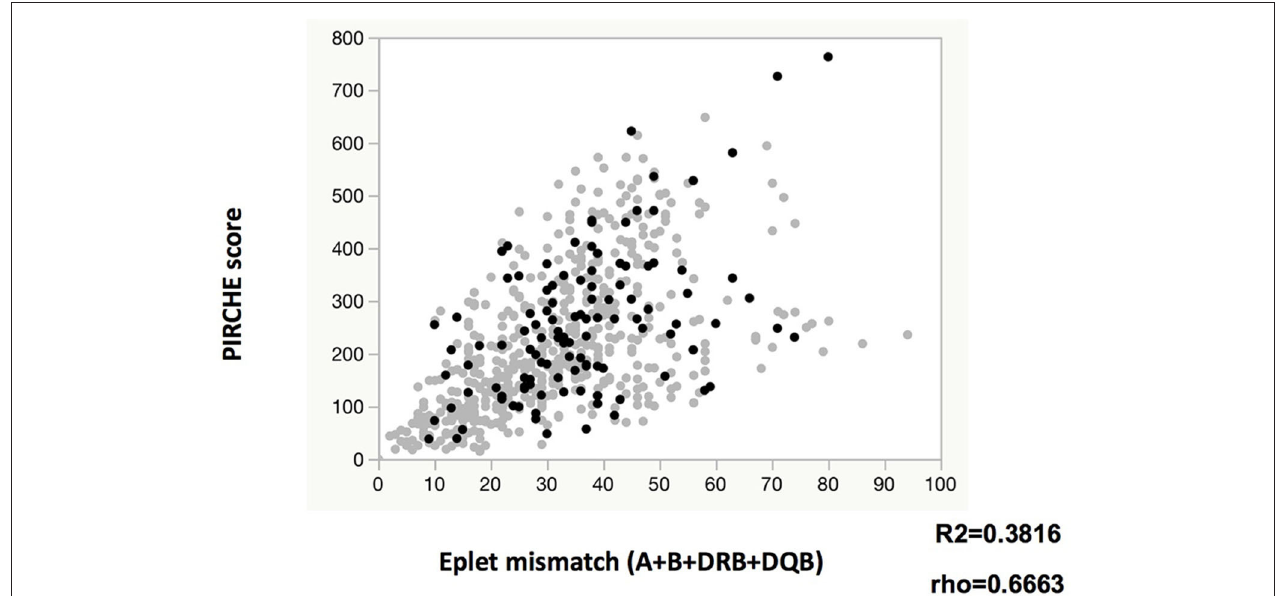
FIGURE 1 | Relationship between eplet mismatch and PIRCHE score. Gray circles and black circles indicate de novo DR/DQ DSA negative and positive, respectively.